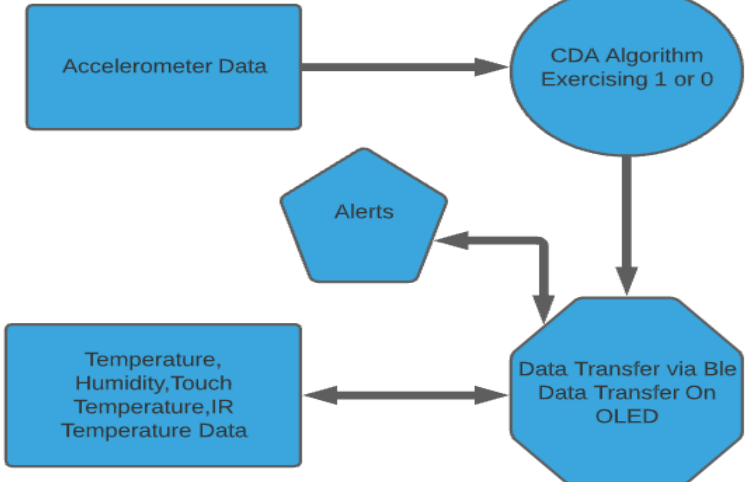
Figure 2. Principle of operation of the designed system .